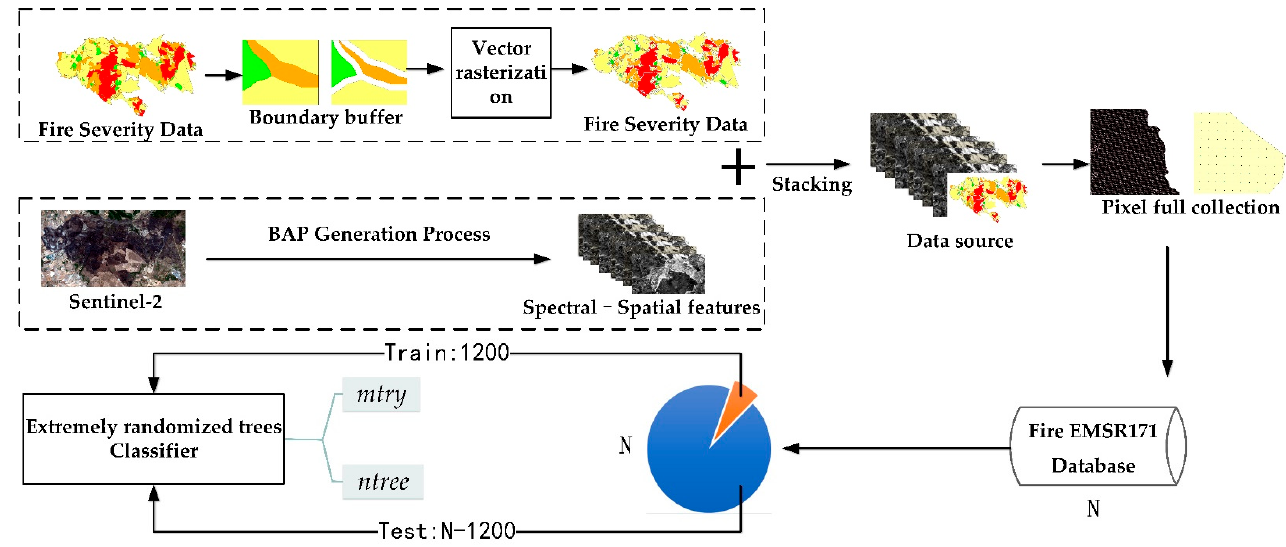
Figure 6. The sample collection process for the EMSR171 fire.